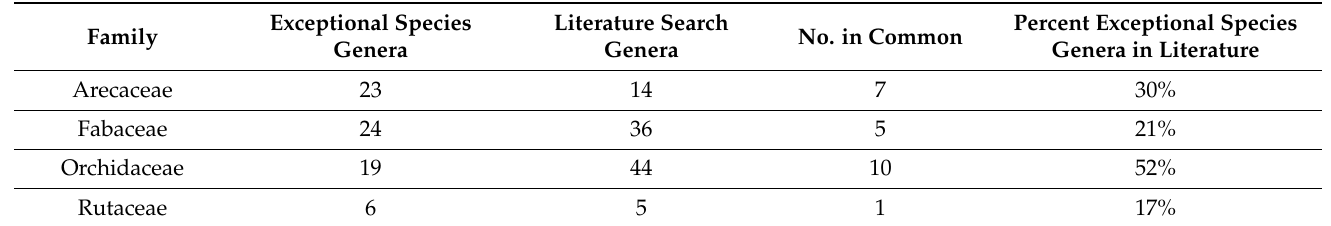
Table 3. Genera in common between the Exceptional Plant List and the Web of Science literature search, for the three families in both the top 10 families on the Exceptional Plant List and the top 10 families with the most articles from the literature search.